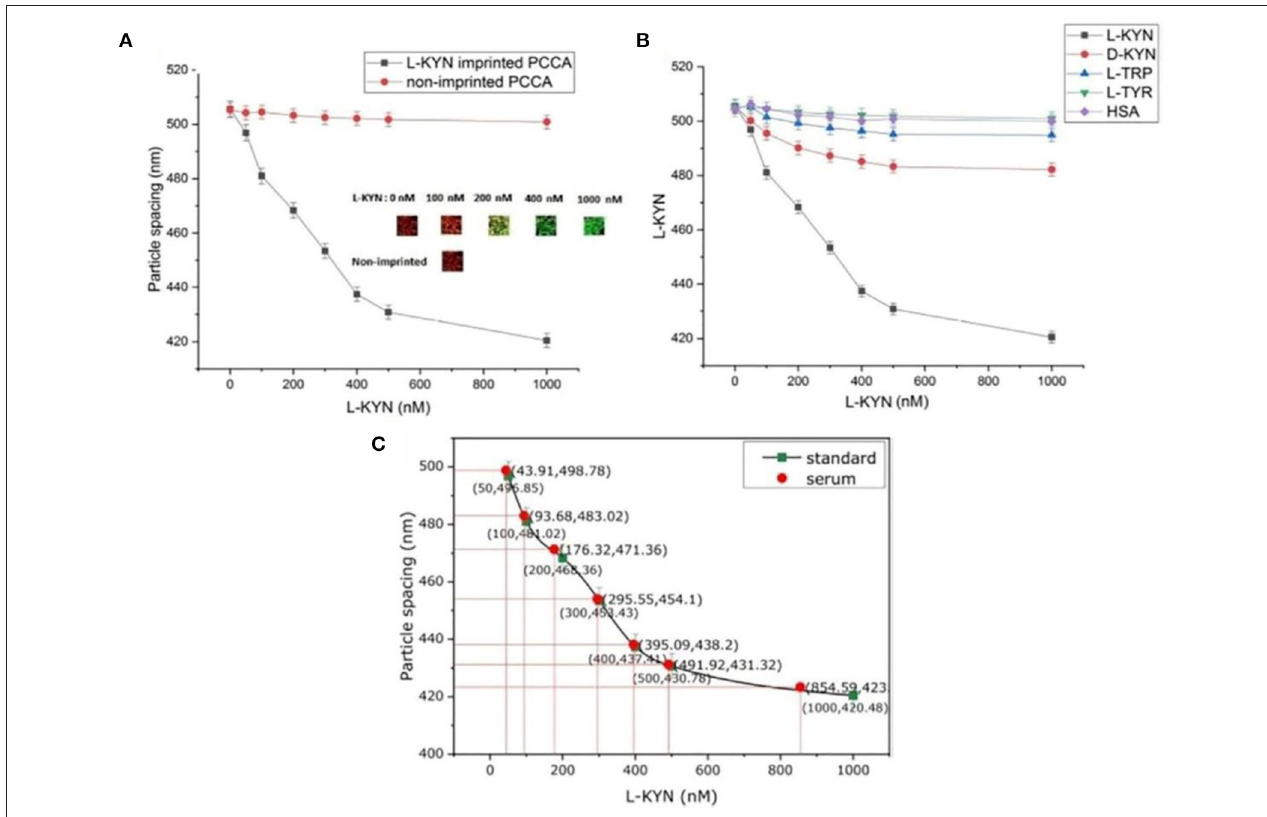
FIGURE 8 | (A) Detection of L-KYN by imprinted photonic crystal colloidal array (PCCA) hydrogel; (B) selectivity of L-KYN imprinted 2D PCCA hydrogel; and (C) determination of L-KYN in human serum (reprinted with the permission of Rizvi et al., 2020; Copyright 2020